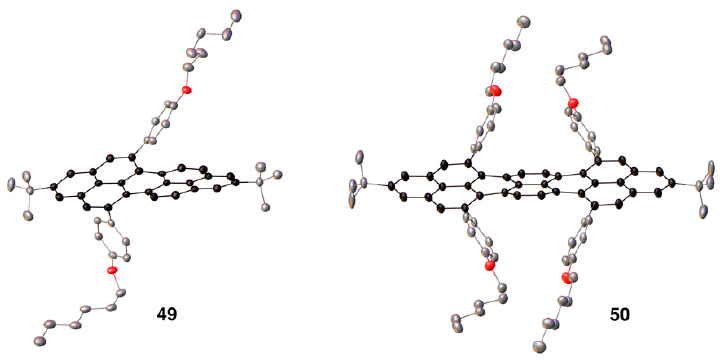
Figure 1. X-ray crystal structures of peropyrene 49 and teropyrene 50 .